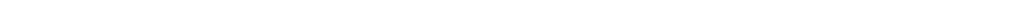
laminin (Fig. 4j, k). The significant reduction in the peri- cyte marker NG2, increase in the fibroblast markers FSP1 and vimentin, and promotion of extracellular matrix col- lagen I and laminin expression were further confirmed by Western blot assay after Mye-CM stimulation (Fig. 4l–o).